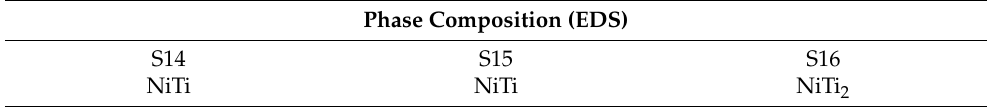
Figure 8. Micrographies of 3D object from filament C (addition of 5 wt.% TiH 2 ). ( a ) after sintering (SEM), ( b ) selected zones for evaluation of Ni:Ti ratio (S14, S15 and S16) by SEM/EDS.